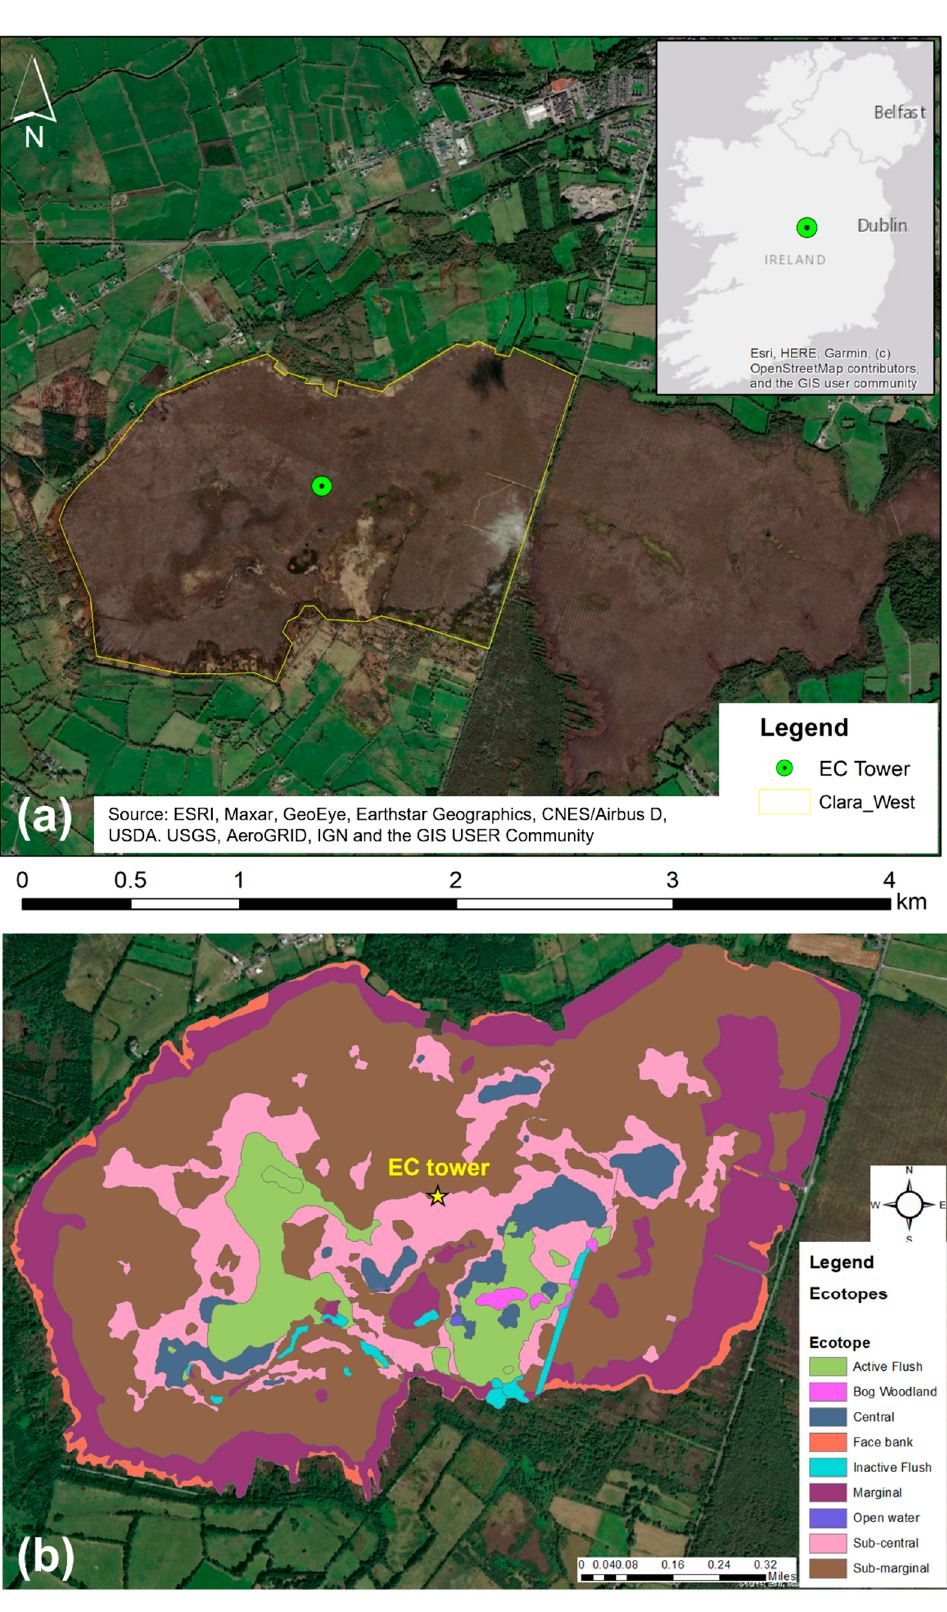
Figure 1. ( a ) A map of Clara Bog showing the delineation of the bog into the eastern and western sections (the western section boundary highlighted in yellow) and the location of the EC tower. ( b ) Ecotope map of Clara Bog West (EU LIFE Irish Raised Bog Restoration Project (LIFE14 NAT/IE/000032)), with EC tower location shown in yellow.